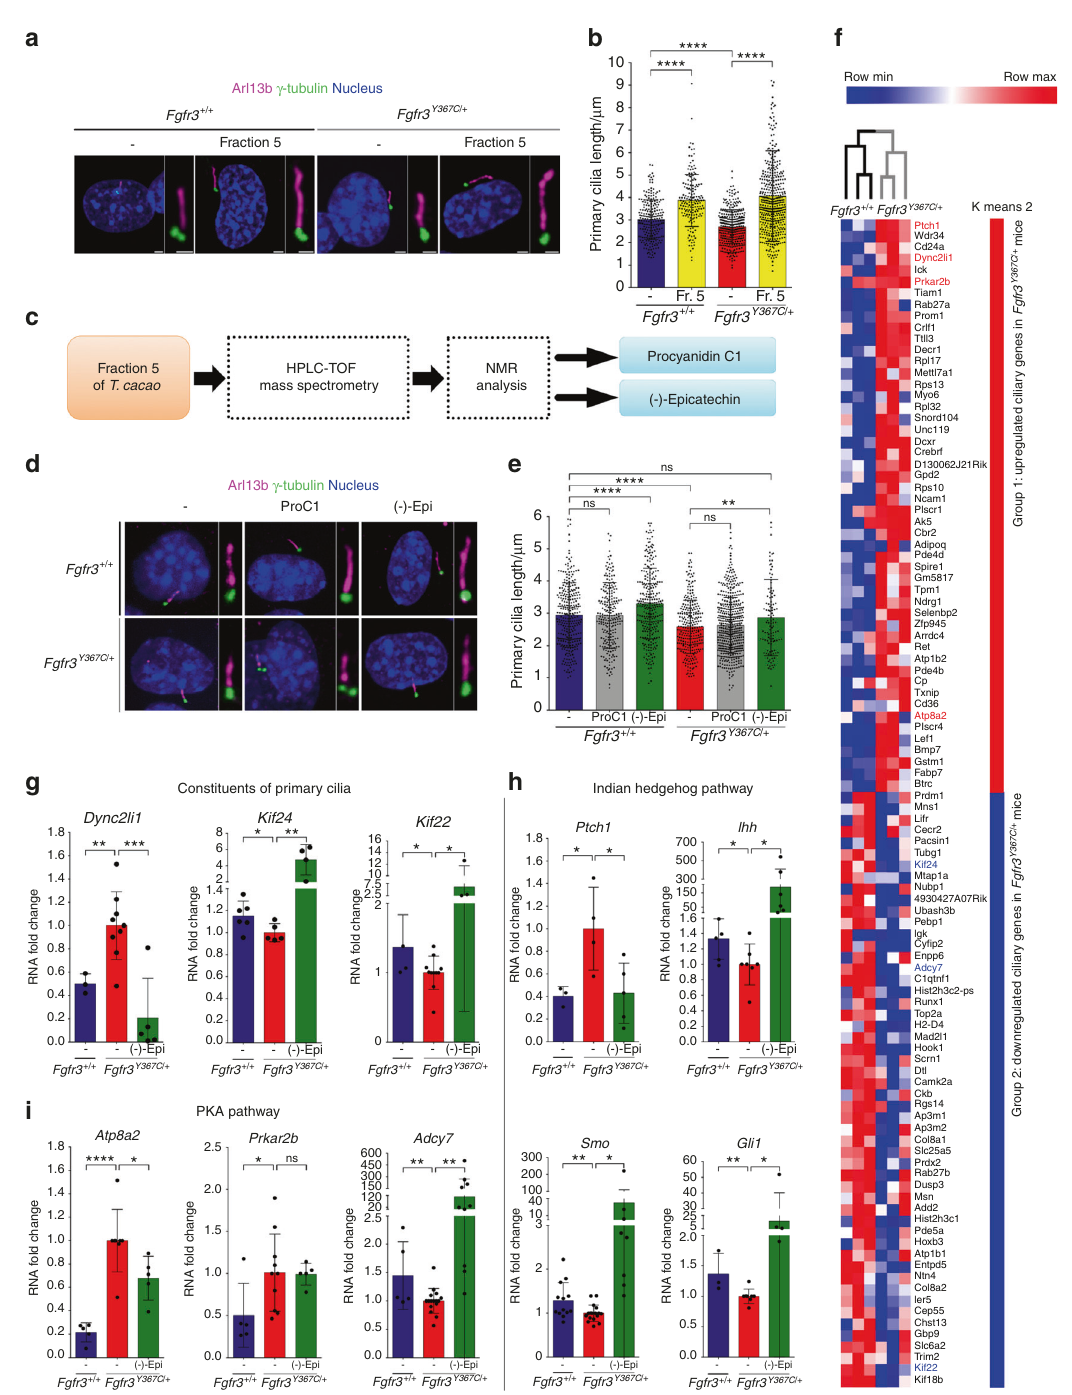
Fig. 1 (-)-Epicatechin from Theobroma cacao fraction 5 modi fi es both ciliary length and ciliary gene expression. a Representative confocal microscopy image of the primary cilia of E16.5 chondrocytes immunolabeled with Arl13b (magenta) for axoneme, γ -tubulin (green) for the basal body, and DAPI (blue) for cell nuclei. b Graphical representation of the length of the primary cilium in E16.5 Fgfr3 + / + ( n = 219 and n = 162 for exposed cells) and Fgfr3 Y367C/ + murine chondrocytes exposed ( n = 338) or not ( n = 443) to fraction 5 of Theobroma cacao . c Sequential representation of the identi fi cation of two major compounds (procyanidin C1 and (-)-epicatechin) in Theobroma cacao fraction 5. d Representative confocal microscopy image of the E16.5 primary cilium immunolabeled with Arl13b (magenta), γ -tubulin (green), and DAPI (blue). e Graphical representation of the length of the primary cilium in E16.5 Fgfr3 + / + not exposed (2.95 ± 0.06; n = 300), exposed to procyanidin C1 (2.94 ± 1.02; n = 232) or exposed to (-)-epicatechin (3.30 ± 1.10; n = 278) and Fgfr3 Y367C/ + murine chondrocytes not exposed (2.58 ± 0.82; n = 272), exposed to procyanidin C1 (2.62 ± 0.87; n = 461) or exposed to (-)-epicatechin (2.87 ± 1.18; n = 113). f Heatmap from a comparative transcriptome analysis of the upregulated (red) and downregulated (blue) genes in growth plate cartilage from 1-week-old Fgfr3 + / + and Fgfr3 Y367C/ + mice. g RNA expression fold change for Dync2li1 , Kif24 , and Kif22 mRNA. h Fold change in Ptch1 , Ihh , Smo , and Gli1 mRNA expression. i RNA expression fold change for Atp8a2 , Prkar2 , and Adcy7 mRNA. Data are presented as the mean ± SEM. ns not signi fi cant; *P < 0.05; **P < 0.01; ***P < 0.001; ****P < 0.000 1 by two-tailed, unpaired t